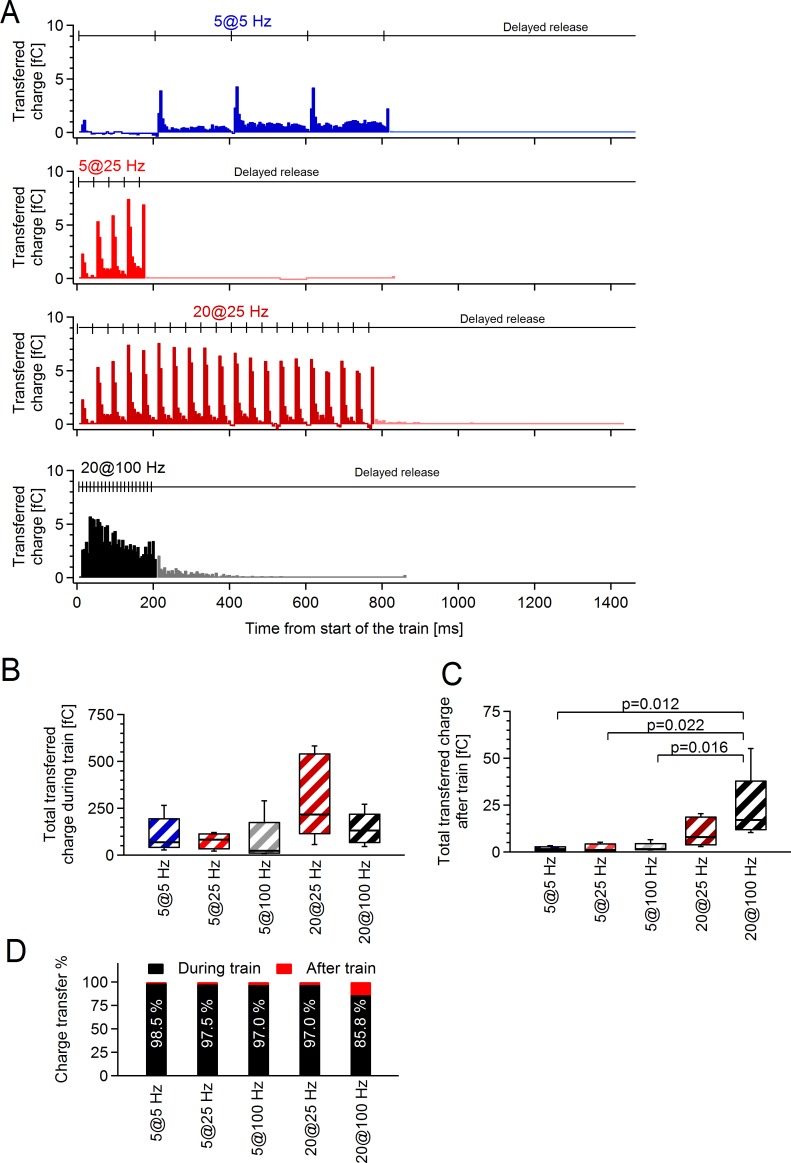
The time course and the amount of synaptic charge transfer through alpha-amino-3-hydroxy-5-methyl-4-isoxazolepropionic acid (AMPA) receptors at axon–oligodendrocyte precursor cell (OPC) synapses depend on the stimulation paradigm.(A) Average synaptic charge transfer upon stimulation of callosal axons with trains of four different frequencies and durations plotted versus real time. Each color (blue, red, dark red, or black) represents mean charge transfer from n = 5 cells (5 pulses at 5 Hz), n = 5 cells (5 pulses at 25 Hz), n = 5 cells (20 pulses at 25 Hz), and n = 10 cells (20 pulses at 100 Hz). Charge transfer is shown in 5-ms bins. Note that plotting charge transfer versus real time allows observing not only the amount of synaptic facilitation but also its distribution over time, and it differs dramatically depending on the stimulation paradigm (Fig 3A & 3D). (B) Total average synaptic charge transfer during the stimulation trains of different frequencies and durations. Both phasic and asynchronous charge transfer during the trains are considered for these bar graphs. The same cells used as in (A). One-way ANOVA (S9 Data). (C) Total synaptic charge transferred by the delayed currents occurring after the stimulation trains of different frequencies and durations. The same cells used as in (A). One-way ANOVA (S9 Data). (D) Percentage contribution of synaptic charge transferred during (phasic + asynchronous charge) and after (delayed charge) the stimulation trains of different frequencies and durations. White numbers on the bars indicate the proportion of charge transferred during the train. Box and whisker plots: the bottom and top of each box represent 25th and 75th percentiles of the data, respectively, while whiskers represent 10th and 90th percentiles. The midline represents the median. The numerical data used in B–C are included in S10 Data.